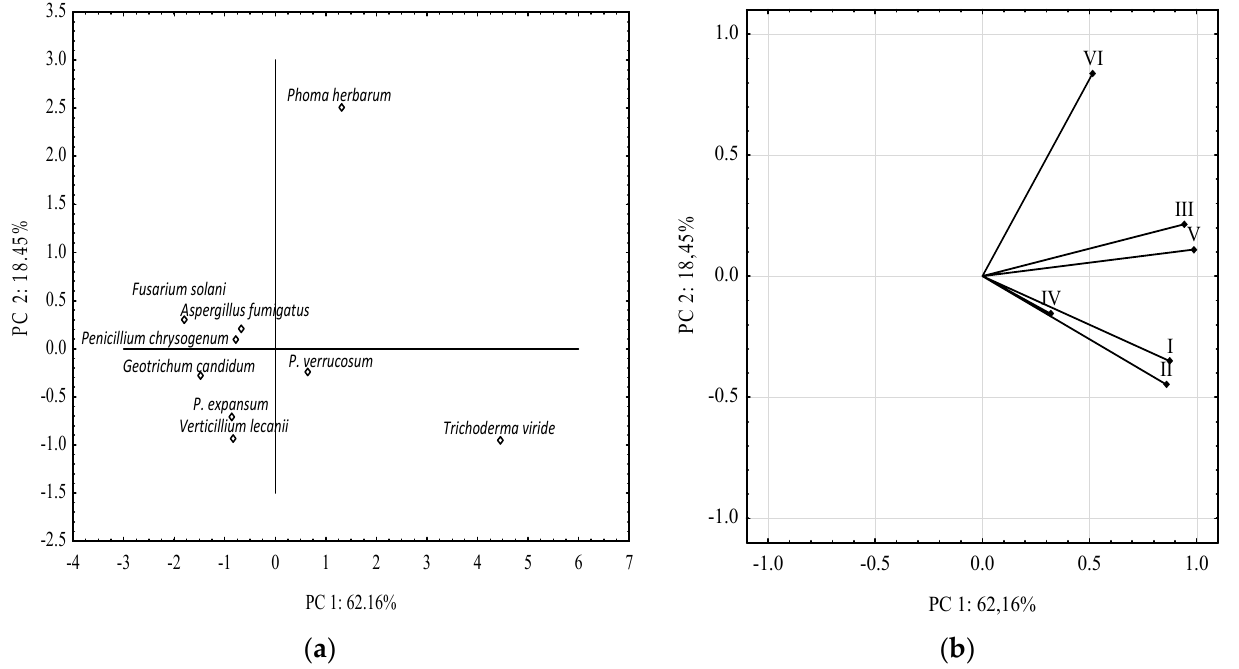
Figure 4. Principal component analysis PCA of the distribution of dominant populations of fungi ( a ) in relation to the type of treatment plant ( b ); Explanations: the model explained 80.61% of the variability by two principal components (PC1 and PC2). Wastewater treatment plants I (92%), II (96%), and V (77%) were significantly correlated with the PC1 variable. Wastewater treatment plant IV was significantly correlated with the PC2 variable. Table 5. Species similarity coefficients (S—expressed in %) of fungal communities in the analyzed small wastewater treatment plants; *—detection of species on Martin medium (2008/2009) and Sabouraud medium (2008), total; I—Leitnie, II—Ludwin, III—Jastk ó w, IV—D ˛abrowica, V—Jan ó w,